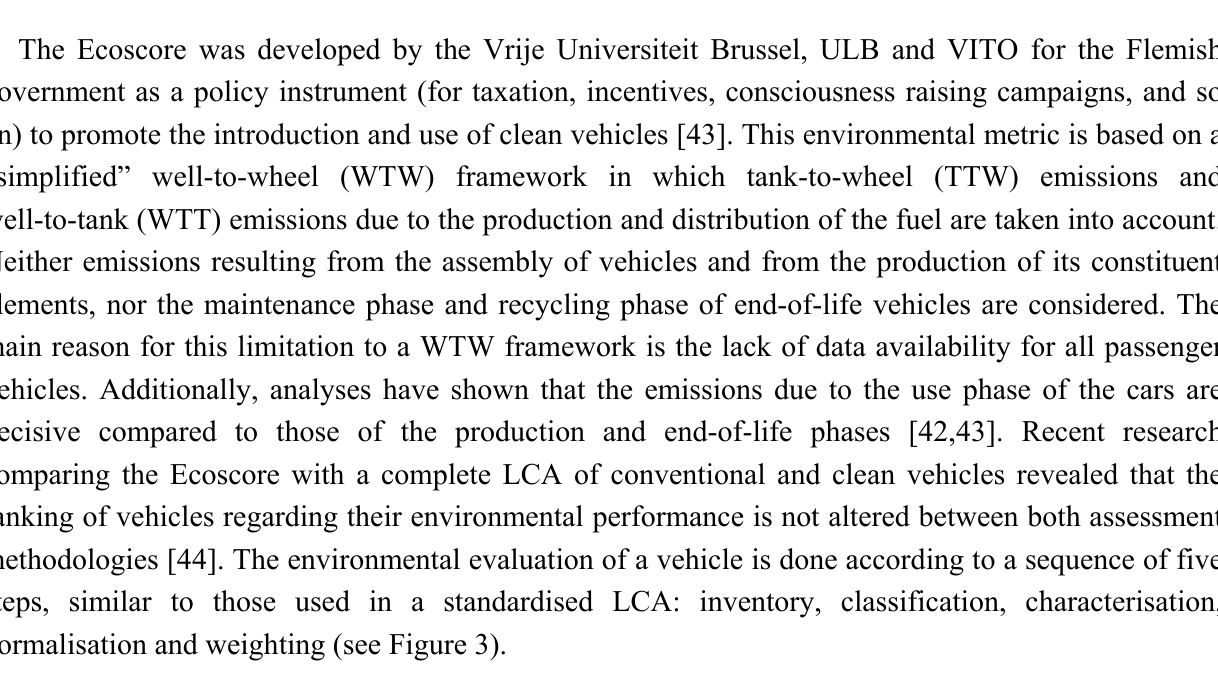
Figure 3. Overview of the Ecoscore methodology (Source: [7], adapted by Maarten Messagie